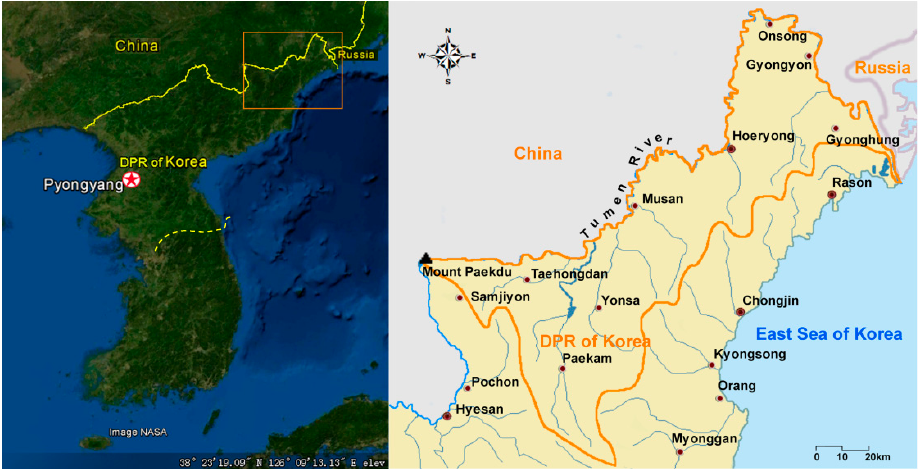
Figure 13. Tumen River Basin (DPR Korea side).